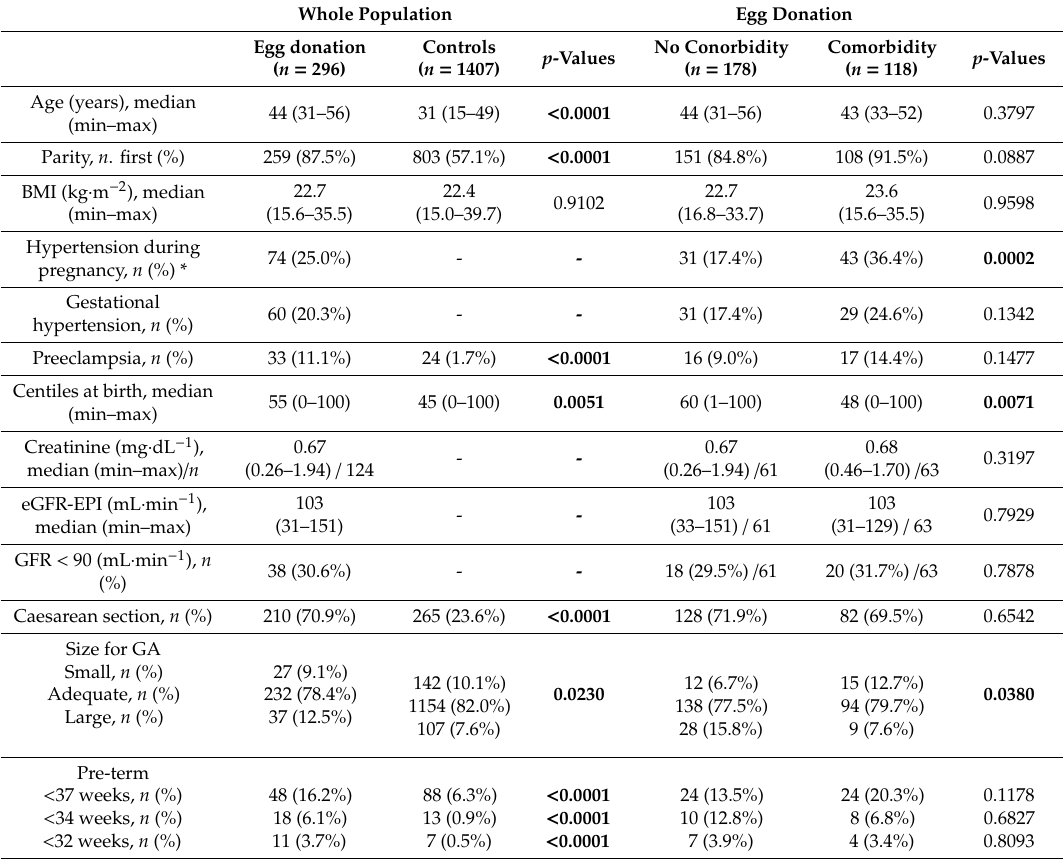
Table 1. Baseline and main delivery data in pregnancies from egg donation and in